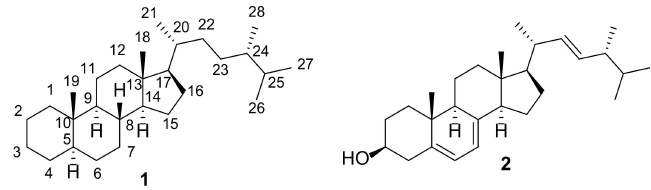
Figure 1. 5 α -Ergostane skeleton 1 and structure of ergosterol ( 2